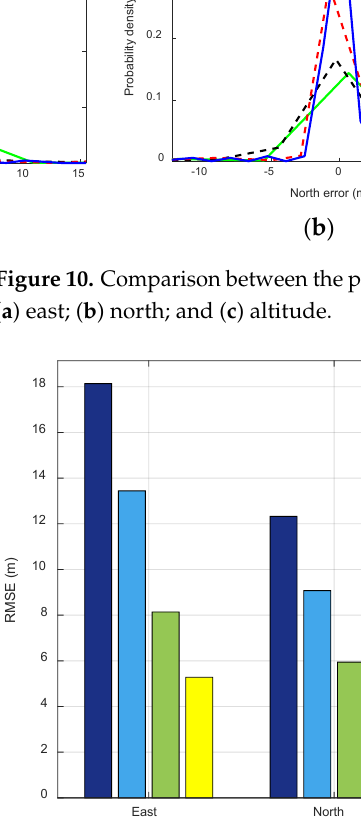
Figure 11. Comparison of the position accuracies in terms of RMSE for the four approaches.